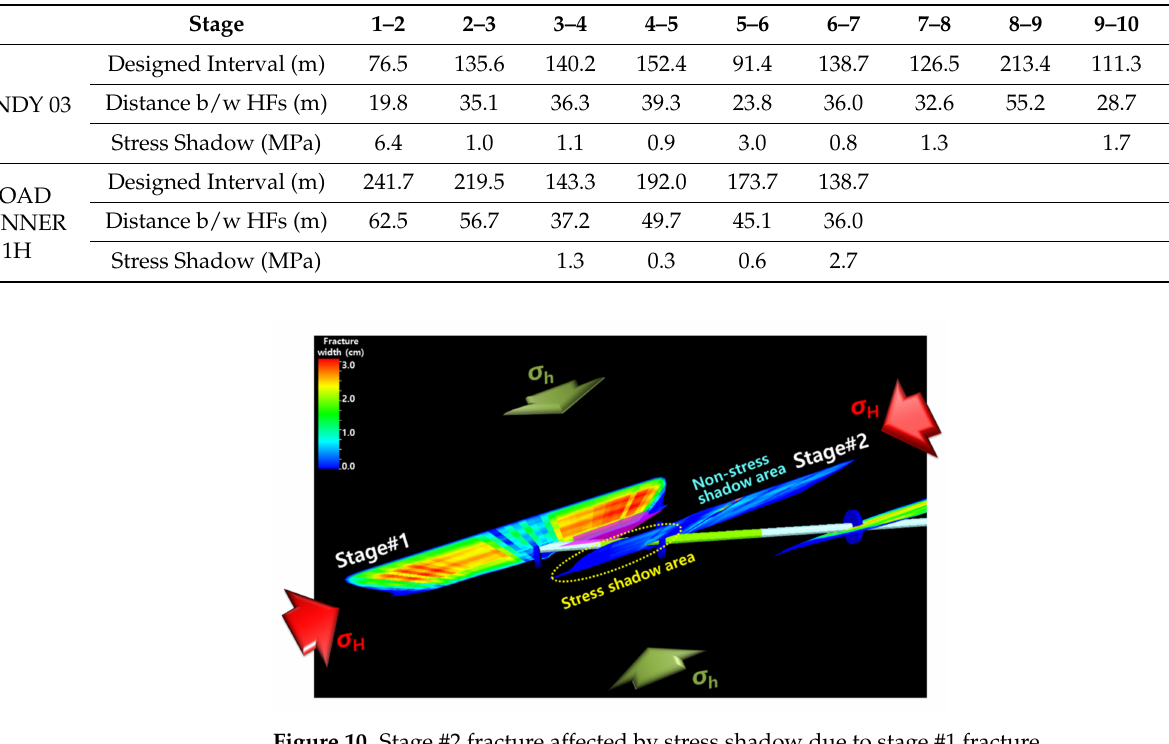
Table 4. Stress shadow occurred by L-dir fractures of horizontal wells drilled toward σ Hmax -dir.